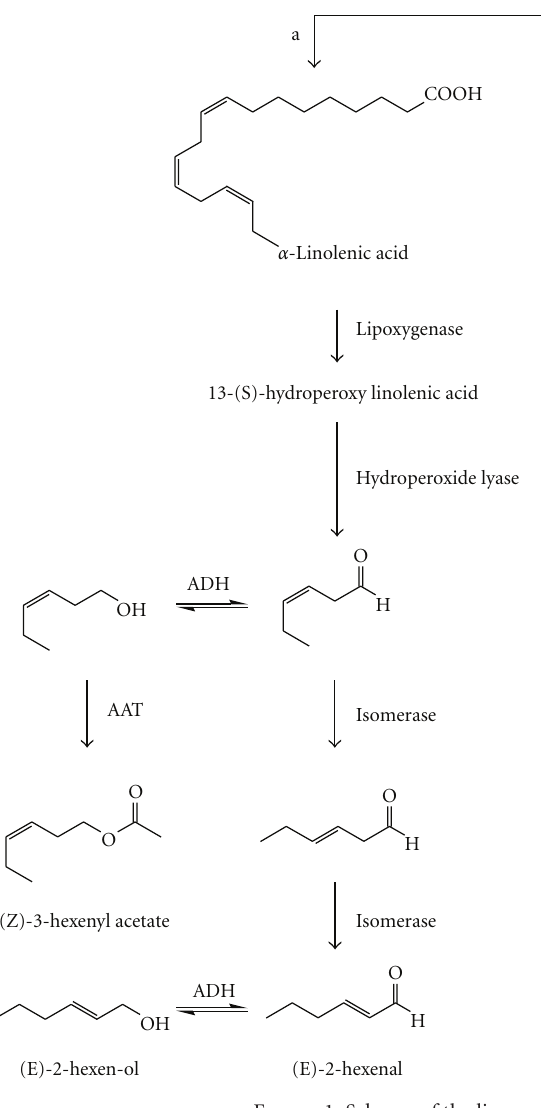
Figure 1: Scheme of the lipoxygenase metabolic